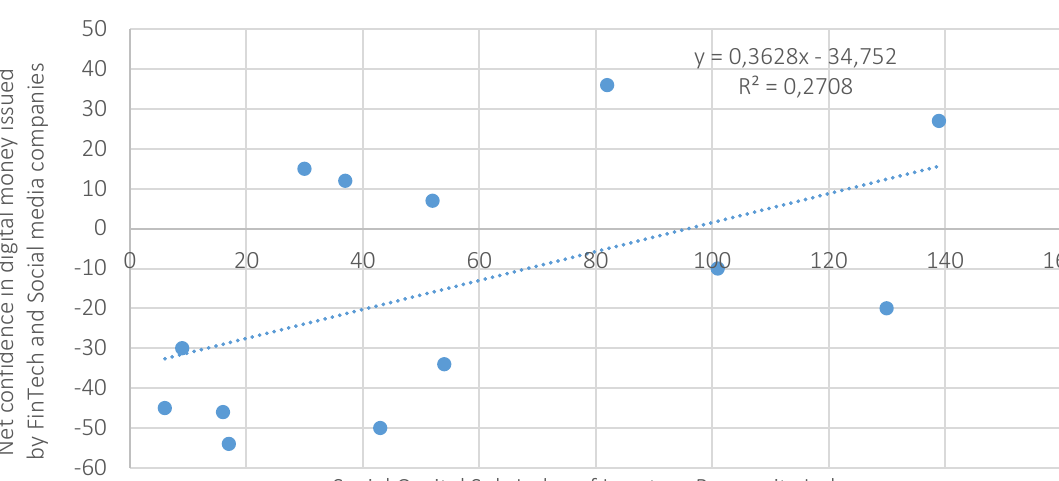
Figure B4. Confidence in privately issued digital money and power distance